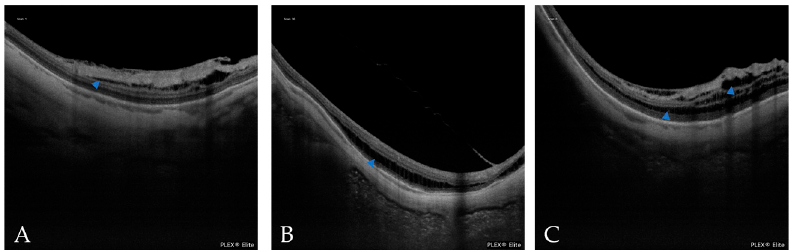
Figure 8. ( A ) An OCT scan of inner retinoschisis. ( B ) An OCT scan of outer retinoschisis. ( C ) An OCT scan of inner and outer retinoschisis. Blue arrowheads indicate the presence of retinoschisis. We also found that 28 (15.6%) eyes had a DSM. Only one eye had associated sub- retinal fluid and OCTA excluded the presence of CNV (Figure 9). We also found a RSM in six eyes, as defined by the IMI OCT classification, four of which were found via vertical scans and were associated with inferior staphyloma.